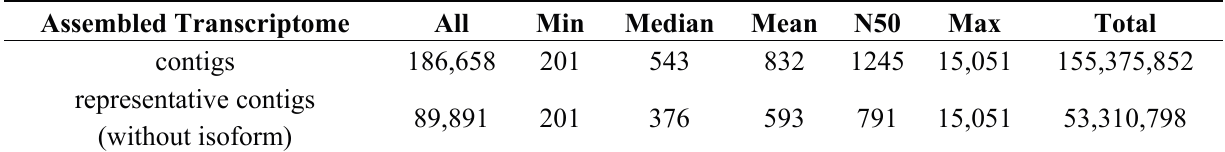
Table 1. Summary statistics of assembled transcriptome length for Apostichopus japonicus coelomocytes.